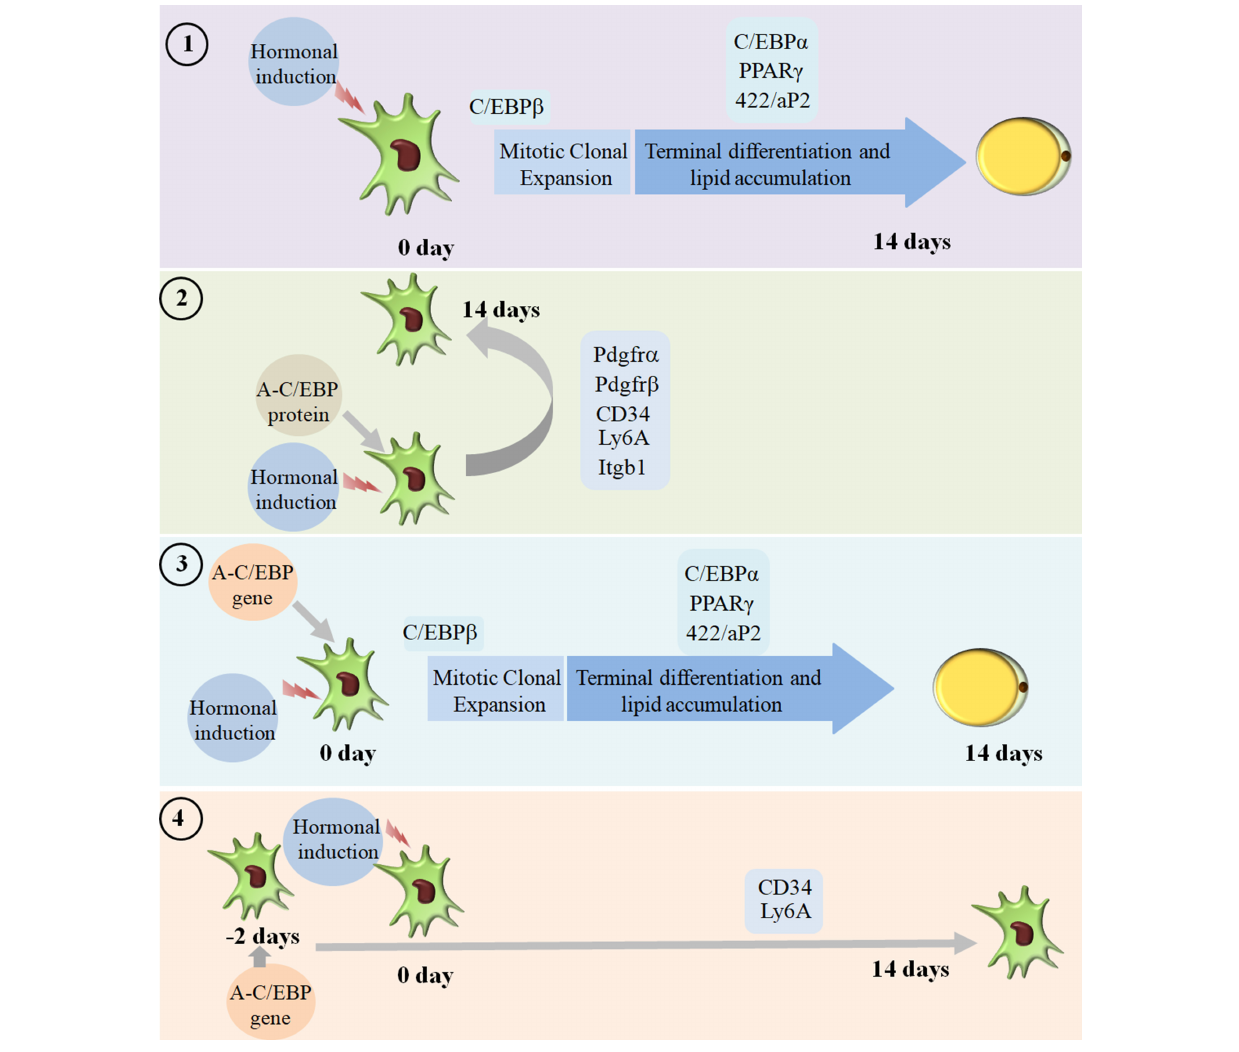
FIGURE 7 | Summary of the studies showcasing the results obtained when 3T3-L1 cells were transfected with A-C/EBP protein and gene. Four experimental conditions are depicted here. (1) Normal differentiation protocol was followed. 0 day defines the day when cells were exposed to MDI cocktail of hormones. The differentiation process takes 14 days that involves MCE and terminal differentiation. Process is marked by transformation of flaccid preadipocytes into lipid-laden mature adipocytes. Only the master regulators of adipogenesis, e.g., C/EBP β , C/EBP α , PPAR γ , and 422/aP2 , is shown. (2) Cells were transfected with A-C/EBP protein for 2h and induced to differentiate. Following the differentiation protocol, the cells were tested for phenotype and analyzed for molecular markers. The cells failed to differentiate as determined by Oil Red O staining. The cells transfected with A-C/EBP protein still express preadipocyte markers 5 days post-differentiation. Five preadipocyte markers were upregulated; among them, Pdgfr α and Pdgfr β are responsible for white adipocyte tissue (WAT) to beige adipocyte cell fate determination. (3) The cells were transfected with A-C/EBP gene for 2h and induced to differentiate. After 14 days, preadipocytes convert into lipid-laden adipocytes with the expression of adipocyte marker genes. (4) The cells were transfected with A-C/EBP gene for 48h and induced to differentiate. After 14 days, the cells were stained with Oil Red O, and the expression profiles of adipocyte differentiation markers were analyzed. Unlike protein samples, only two CD34 and Ly6A preadipocyte markers were